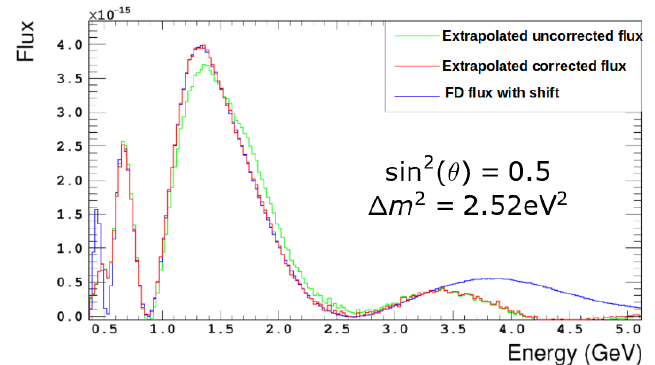
Figure 135. The muon neutrino flux obtained with the DUNE-PRISM technique is shown after a horn shift when ND-LAr and ND-GAr have moved off-axis as described in the